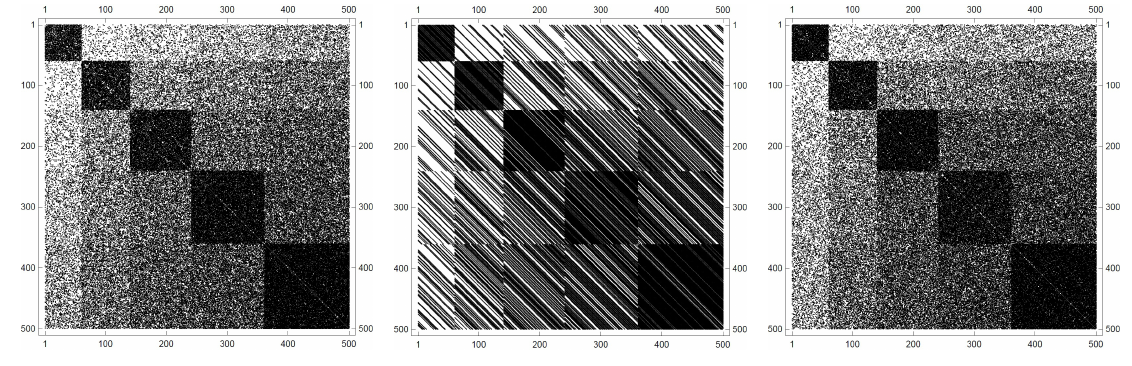
Figure 3: The former generalized quasir- andom graph obtained by appropriate permutation of the vertices within the